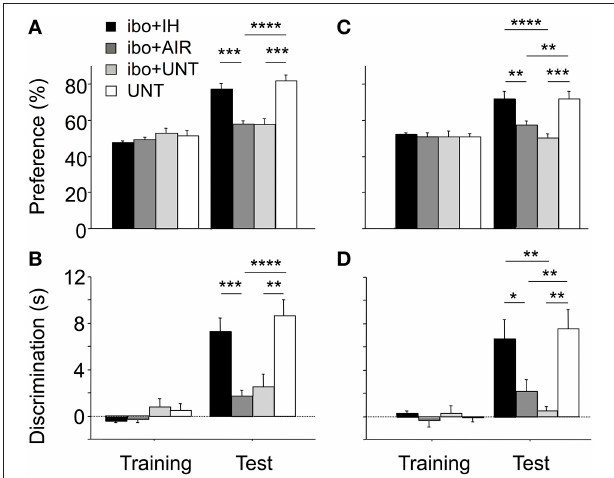
FIGURE 7 | Improvement of memory indices in brain-lesioned mice exposed postnatally to IH. During training for ORT (A,B) and OLT (C,D) , all groups displayed similar exploration of the two objects. (A,B) During the ORT test phase, mice with excitotoxic brain lesions, whether unmanipulated (ibo + UNT, n = 15 ) or exposed to air (ibo + AIR, n = 16 ), displayed significantly lower indices compared to untreated pups left with their dam (UNT, n = 12 ). IH exposure prevented recognition memory dysfunction in mice with excitotoxic brain lesions (ibo + IH, n = 16 ). (C,D) The OLT yielded similar statistical results: IH prevented spatial memory dysfunction in mice with brain lesions. Values are group means ± SEM. * p < 0.05 ; ** p < 0.01 ; *** p < 0.001 ; **** p < 0.0001